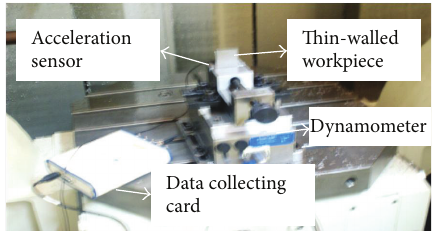
Figure 7: The milling experiments scenes.